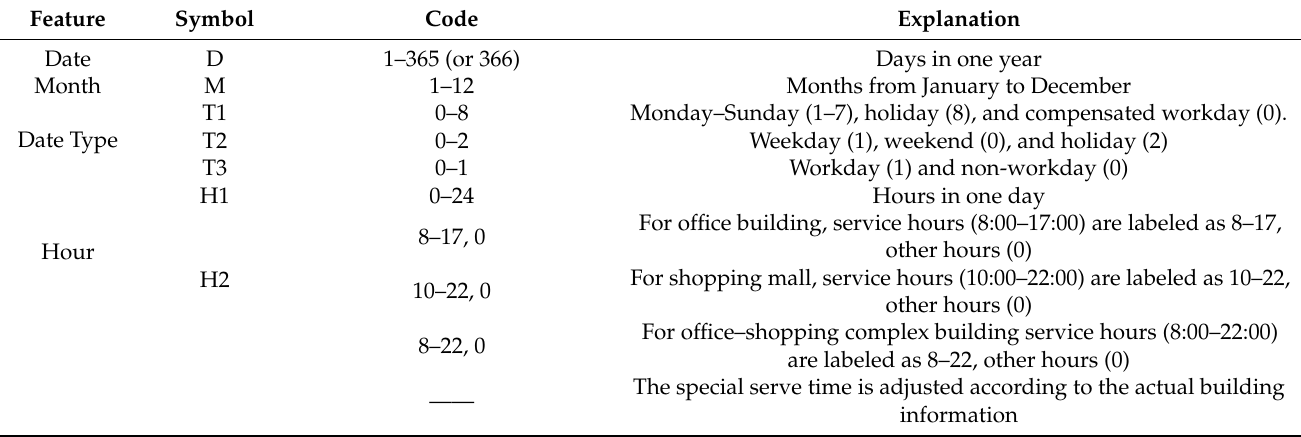
Table 2. Summary of symbols and encoding methods of timestamp features.